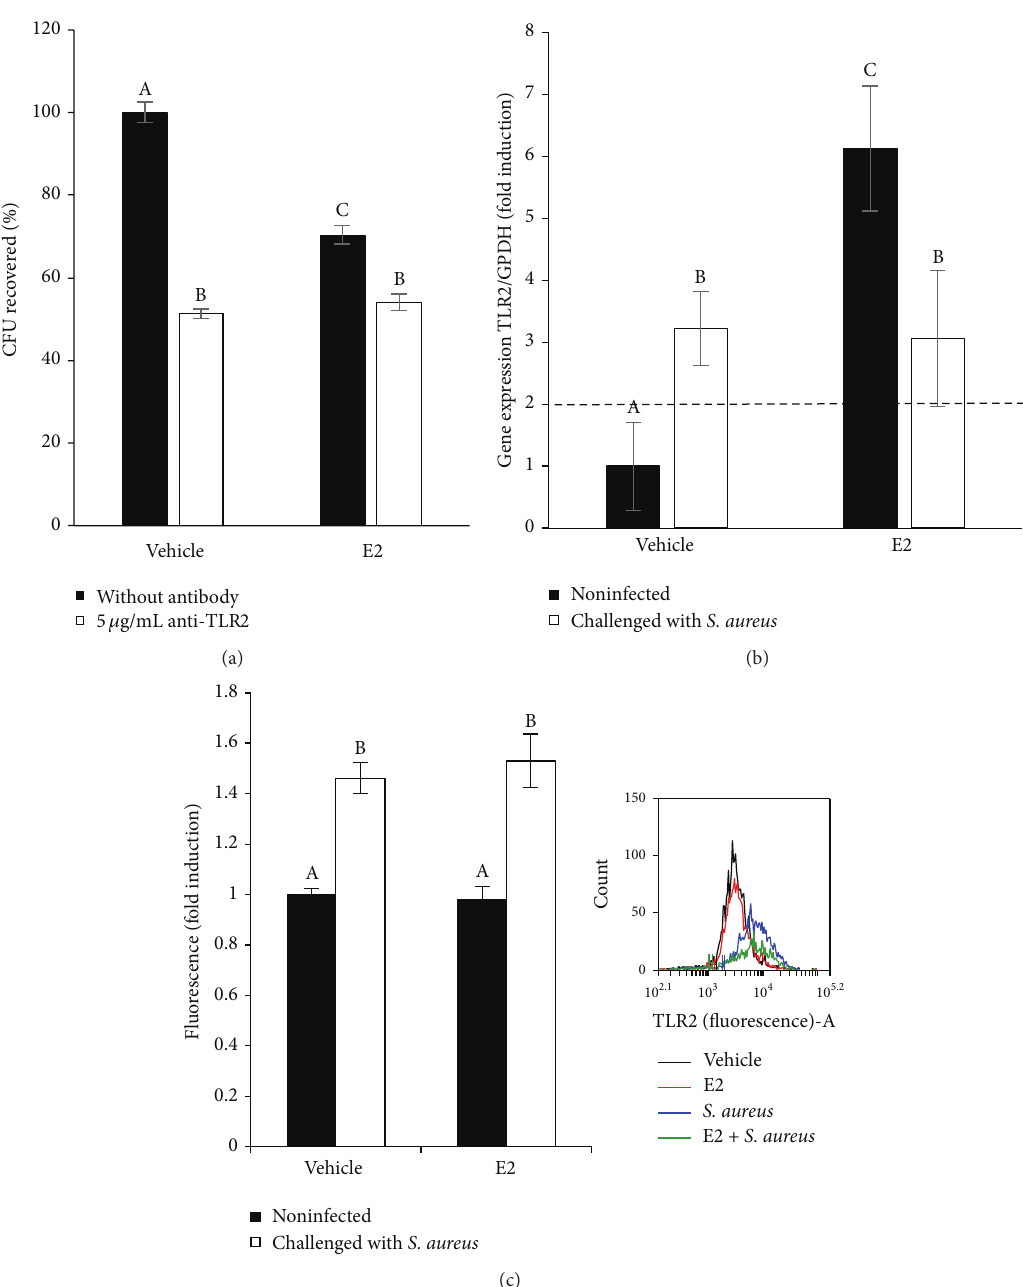
Figure 4: Participation of TLR2 in the internalization of S. aureus by bMECs inhibited with E2. (a) Primary cultures of bMECs treated for 24 h with E2 (50 pg/mL) were incubated with 5 𝜇 g/mL of a specific blocking antibody against TLR2 for 1 h and then challenged with S. aureus (MOI 30 :1 bacteria per cell). The number of internalized bacteria is represented by the ratio of CFU/bMEC recovered after lysis of bMECs. (b) The TLR2 mRNA expression was analyzed by RT-qPCR and GAPDH was used as endogenous gene in all conditions. Fold-change values greater than 2 or less than 0.5 were considered as significant differentially expressed mRNAs. Each bar shows the mean of triplicates ± SD of three independent experiments. (c) The relative fluorescence intensities of TLR2 membrane abundance in bMECs treated with E2 and infected with S. aureus are shown. Fluorescence intensity was estimated from 10,000 events. An inserted histogram plot that shows TLR2 staining data in vehicle-treated bMECs (black line), cells that were challenged with S. aureus (blue line), cells that were stimulated with E2 (red line), and E2-treated bMECs infected with S. aureus (green line). The cells were fixed and stained extracellularly with an anti-TLR2 antibody overnight and analyzed with flow cytometry. Different letters indicate significant changes among treatments ( 𝑃 < 0.05 ). Vehicle: 1%